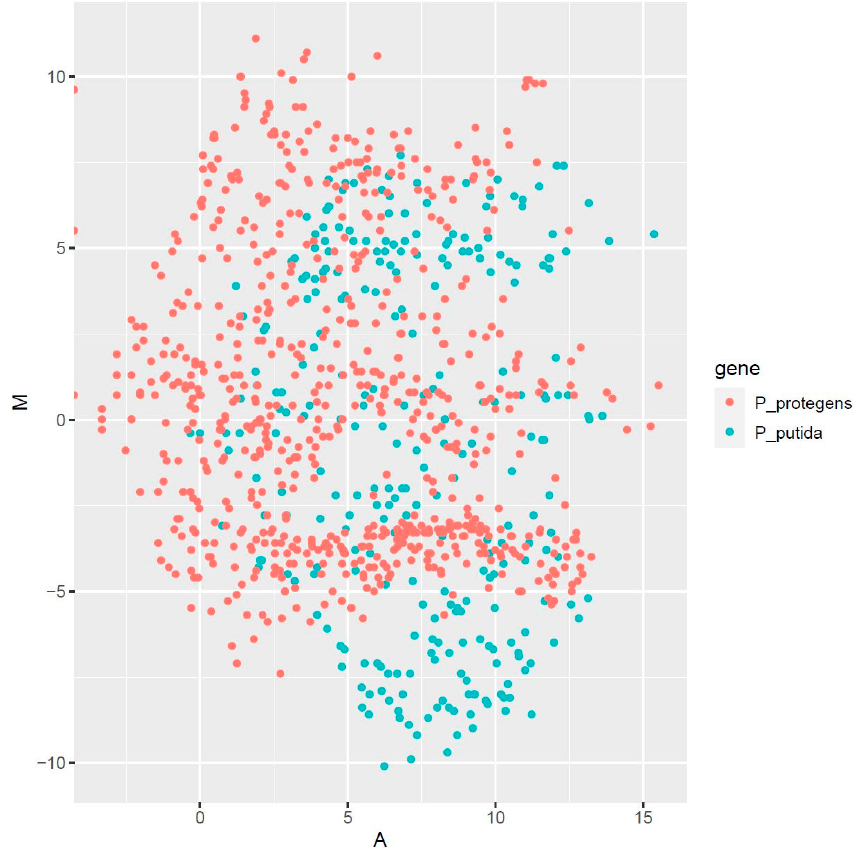
Figure 6. MA plot for differential expression of the genes. M is estimated as log 2 (TPM of the consortium/TPM of the individual strains), whereas A is determined as 0.5 × log 2 (TPM of the consortium x TPM of the individual strains). These values are calculated for all up-regulated genes. Table 2. KEGG hits for pathways expressed by P. protegens in the 1:1 co-culture that exhibit the greatest changes in TPM compared to its metabolic activity in pure